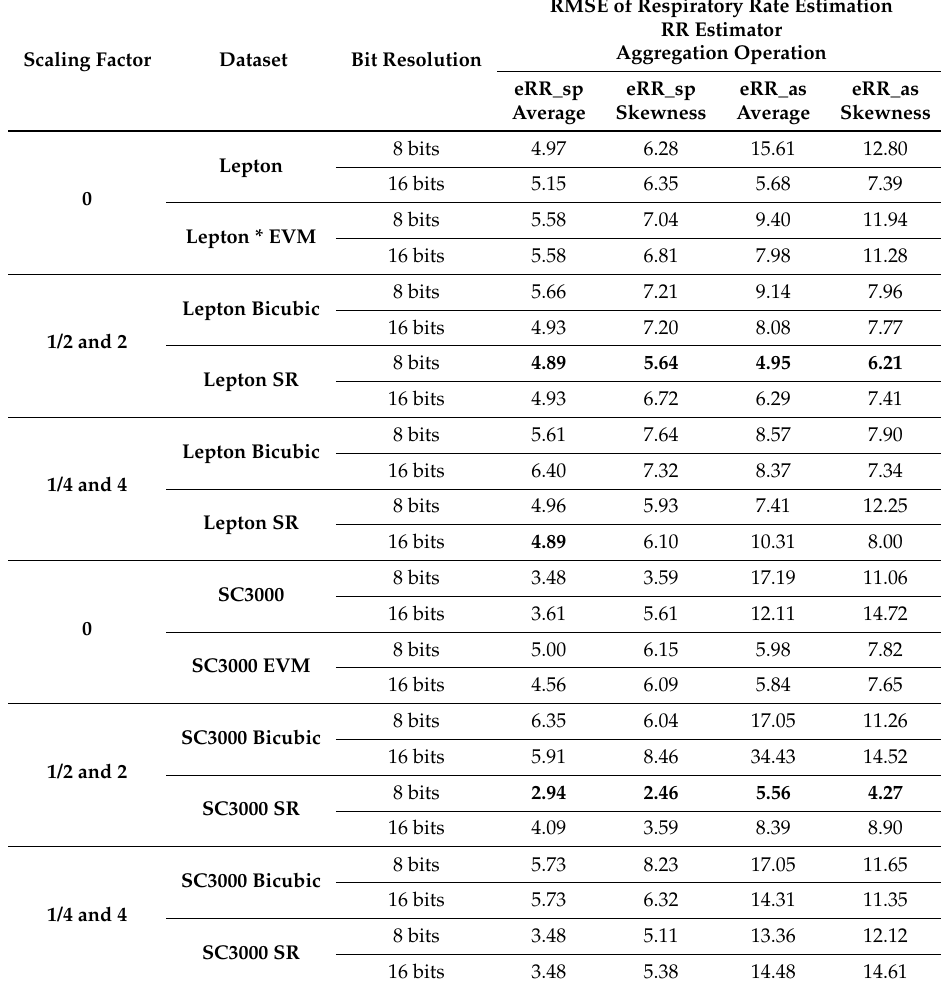
Table 2. Root Mean Square Error calculated using a difference between reference RR values and RR values estimated from thermal sequences using two respiration rate estimators: eRR_sp and eRR_as . Raw pixel values inside manually selected regions of interests were aggregated using average or skewness operators. Best result for each dataset was marked in bold (separately for 8 and 16-bit